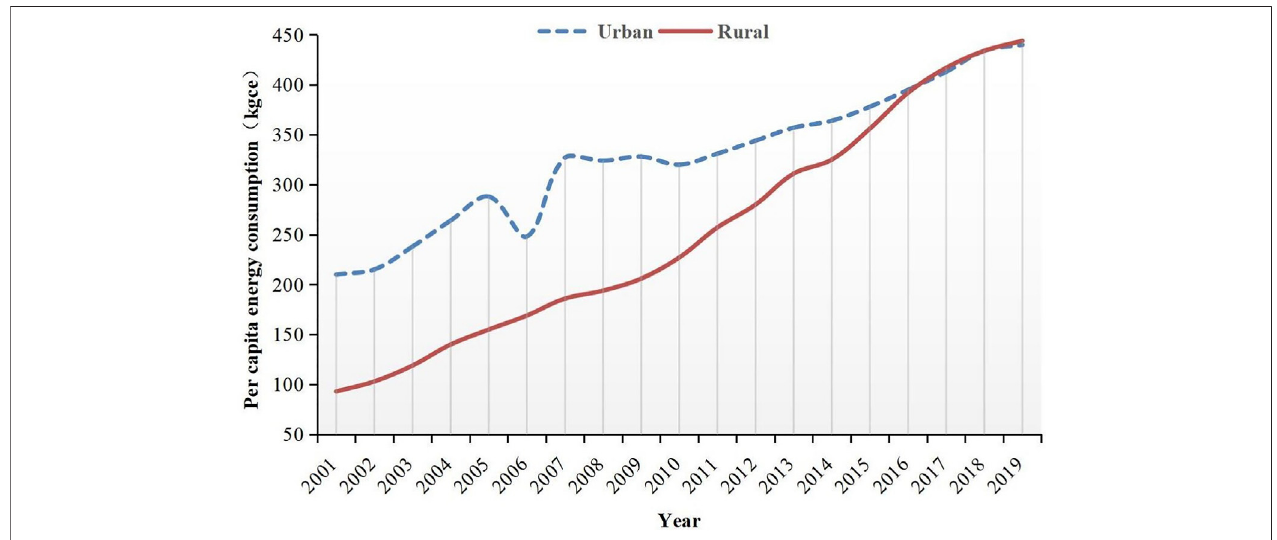
FIGURE 1 | Urban and rural living energy consumption from 2001 to 2019 in